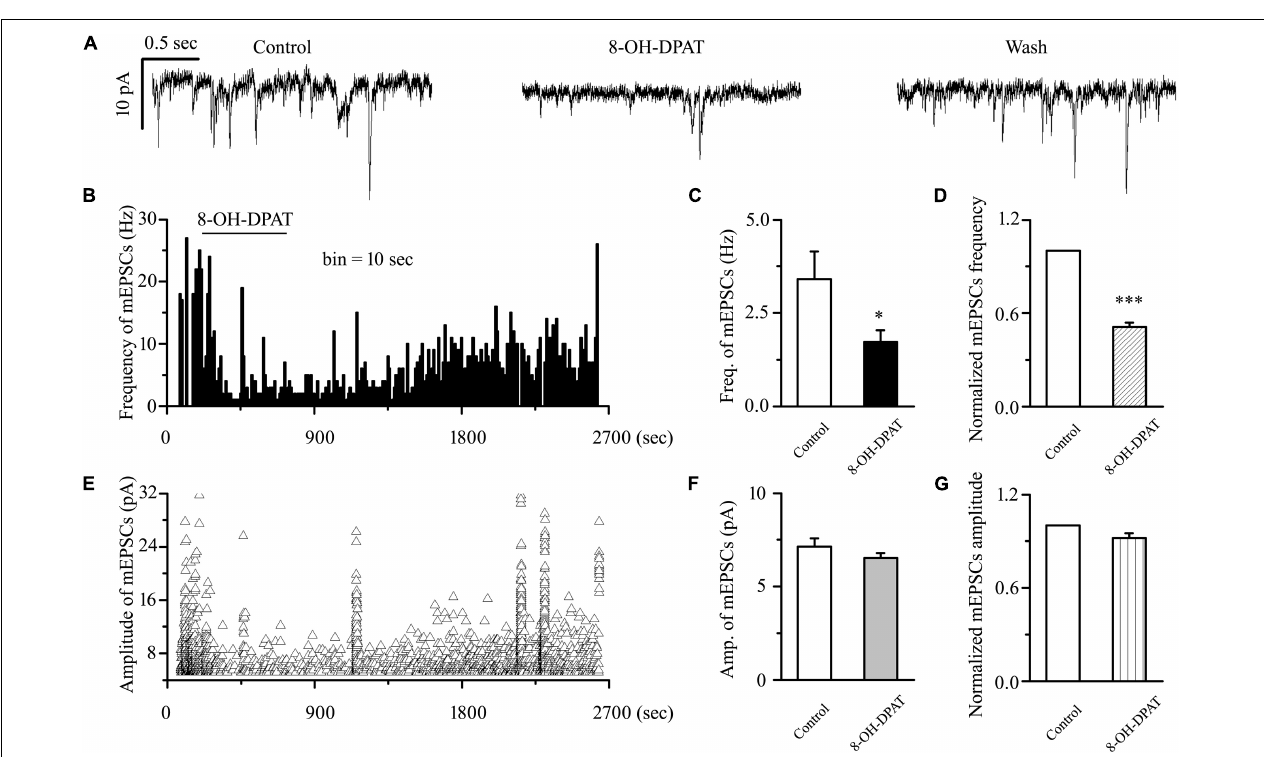
FIGURE 6 | 8-OH-DPAT significantly decreased the frequency, but not the amplitude, of mEPSCs in OFF-type RGCs. (A) Representative traces showing the effect of 10 µ M 8-OH-DPAT on mEPSCs. Vertical scale bar: 10 pA; horizontal scale bar: 0.5 s. (B,E) Frequency (10 s bin) and amplitude histograms of the mEPSCs from the trace in (A) showing the effects of 8-OH-DPAT. Summarized data from 11 RGCs showing that 10 µ M 8-OH-DPAT significantly decreased the average frequency (C) and amplitude (F) of the mEPSCs. (D,G) Normalized mEPSC frequency and amplitude ( n = 11). ∗ p < 0.05 and ∗∗∗ p < 0.001 vs. control, Student’s paired t- test.